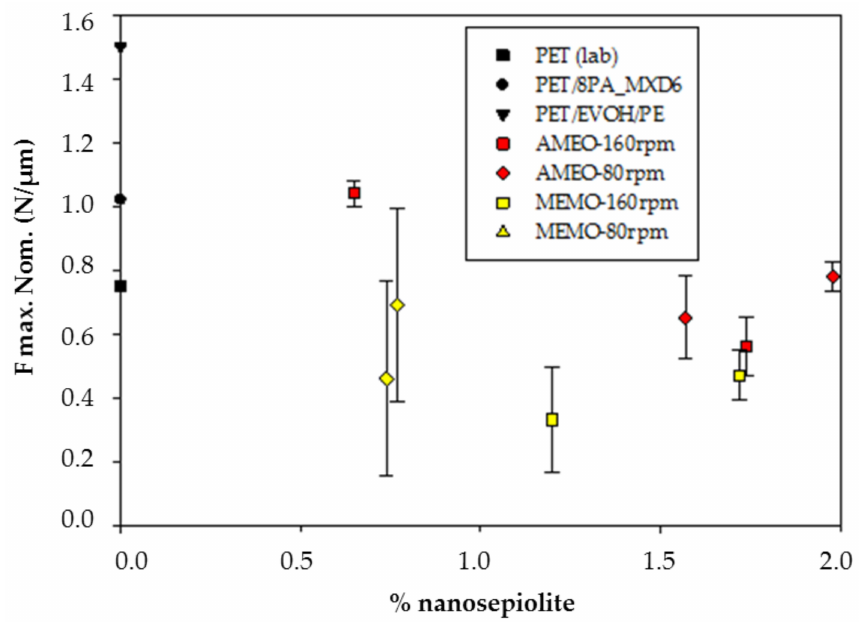
Figure 6. PET/PA_MXD6/nS nanocomposites Normalized Maximum Force as a function of nanose- piolite